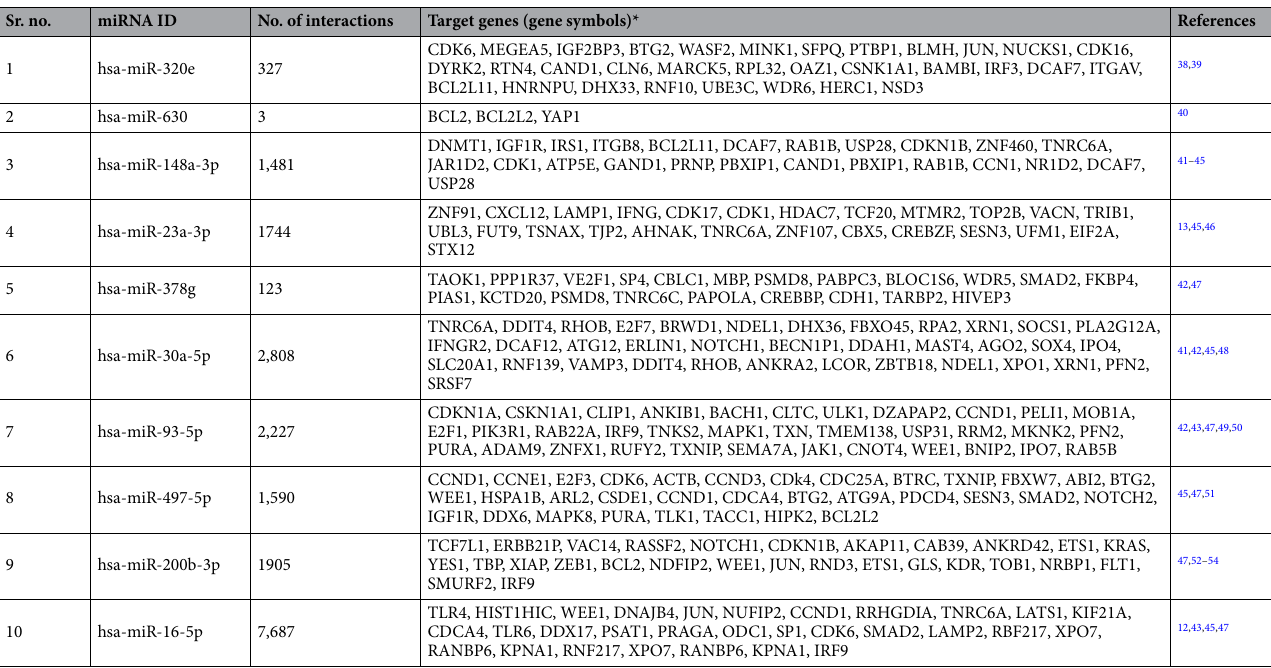
Table 3. Tarbase v8.0 based target genes of the top ten differentially expressed human milk exosomal miRNAs in HIV-1 infected mothers. *Some of the target genes out of total are shown here in the